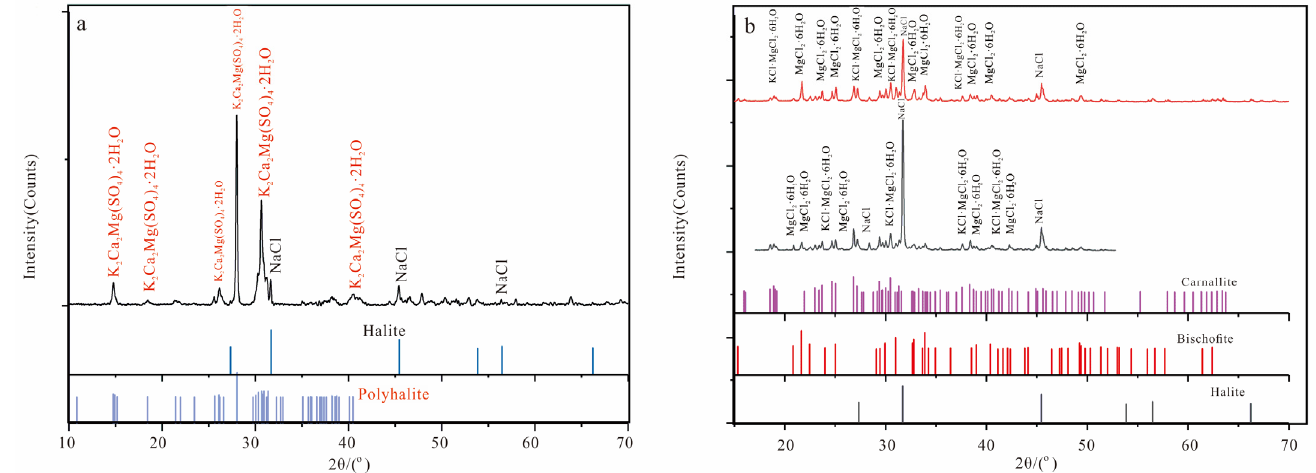
Figure 4. XRD pa tt erns of carnallite and polyhalite; ( a ) pa tt erns of polyhalite and halite in the Lop Figure 4. XRD patterns of carnallite and polyhalite; ( a ) patterns of polyhalite and halite in the Lop Nor basin, ( b ) pa tt erns of carnallite bischo fi te and halite in the Lop Nor basin. Nor basin, ( b ) patterns of carnallite bischofite and halite in the Lop Nor Table 1. Results of X-Ray Di ff raction of samples. Mineral Number *